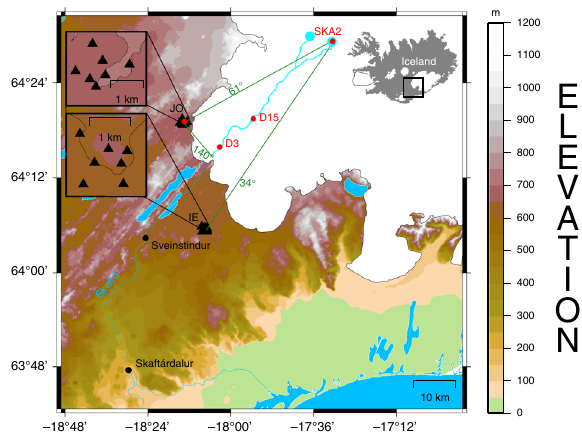
Fig. 1 Overview of the multidisciplinary monitoring network around W-Vatnajökull ice cap. The eastern and western Skaftá cauldron (cyan dots), seismic arrays (black triangles), GPS instruments D3, D15 and SKA2 (red dots), hydrological instruments (black dots), subglacial fl ood paths as in Magnússon et al. (2004) 56 (cyan lines on the glacier) and glacial rivers (cyan lines outside glacier) are marked. Back azimuths from JO and IE array to the eastern cauldron are indicated with green lines. The GPS instruments were installed for research purposes and are not part of the fi xed monitoring network. The insets show an overview of Iceland and the geometry of JO and IE arrays in